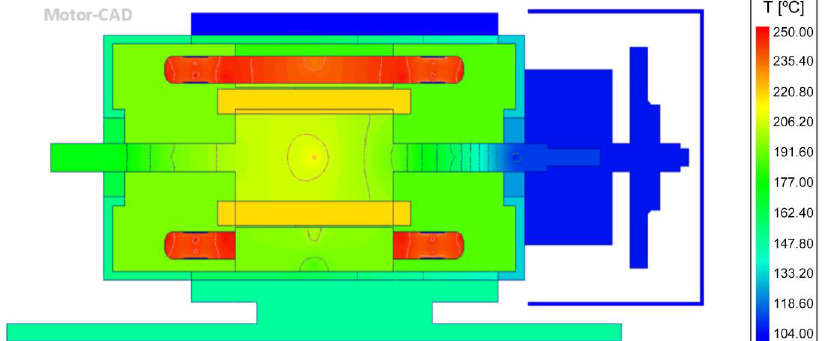
Figure 9. Axial view of motor (fan-cooled) after FEM analysis. Results of the FEM analysis for the air-cooled motor are shown in Table 6. Table 6. Observations after FEM analysis on the air-cooled motor. No. Output Parameter Value 1. Total weight of motor obtained including foot mounted base 13 kg 2.